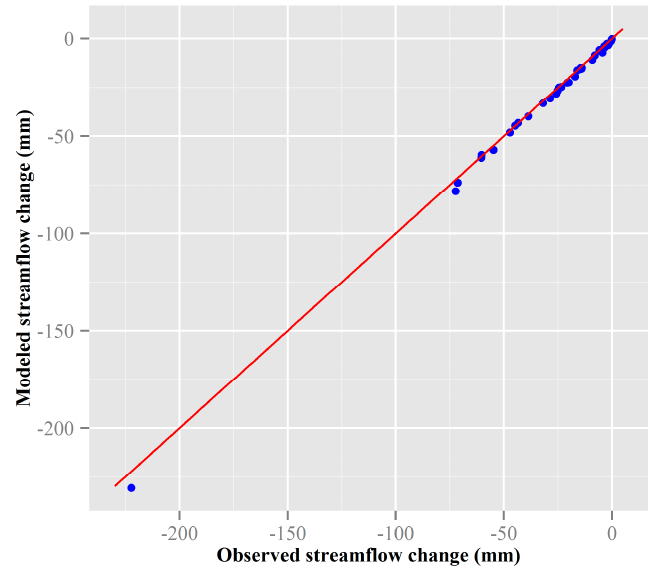
Figure 4. Comparison between the modeled ( ∆ RP + ∆ R n + ∆ RR n + ∆ RT max + ∆ RT min + ∆ R U and observed changes in the average annual streamflow for the years 1960–2000. The red line represents a 1:1 linear relationship.